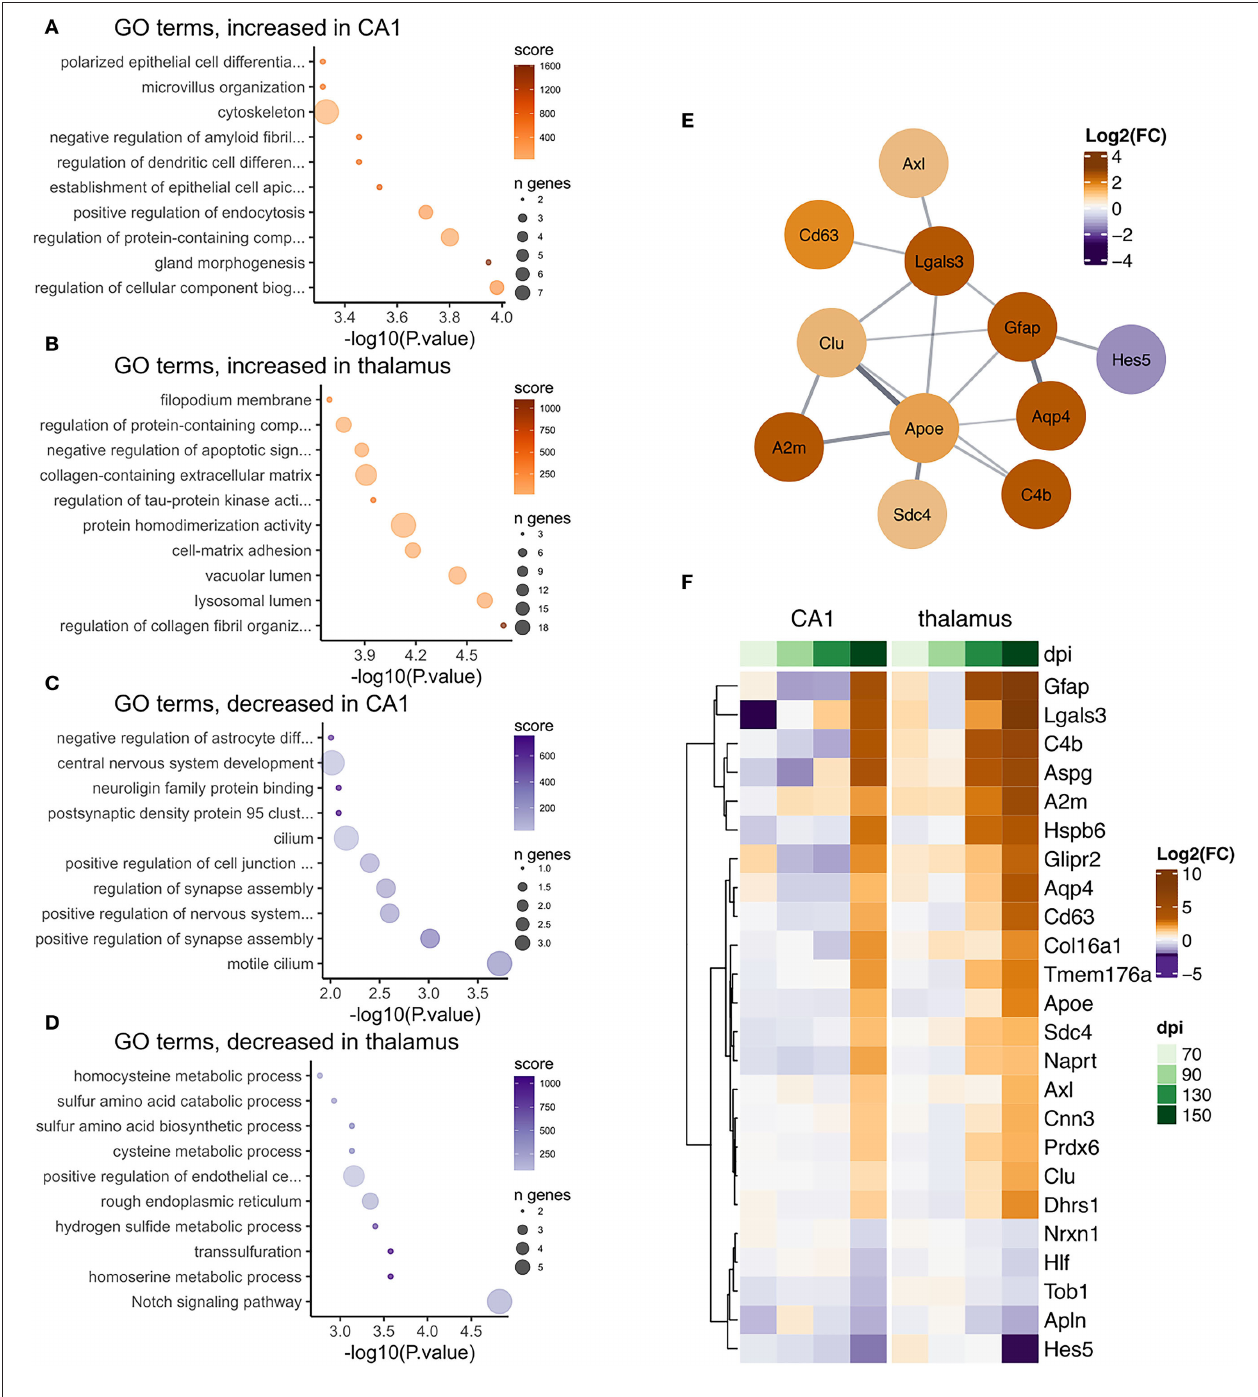
transcription factor Hes5 was commonly decreased between the two regions ( Figure 8F ). A recent study has implicated